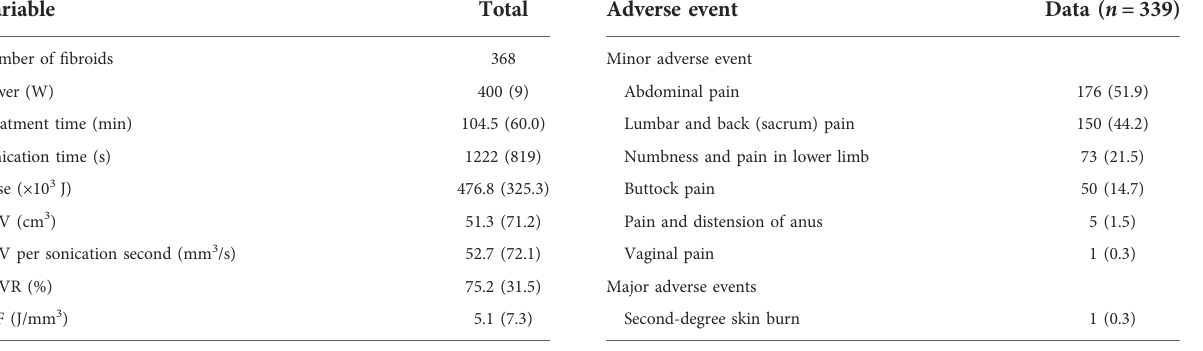
TABLE 2 Adverse events of ultrasound